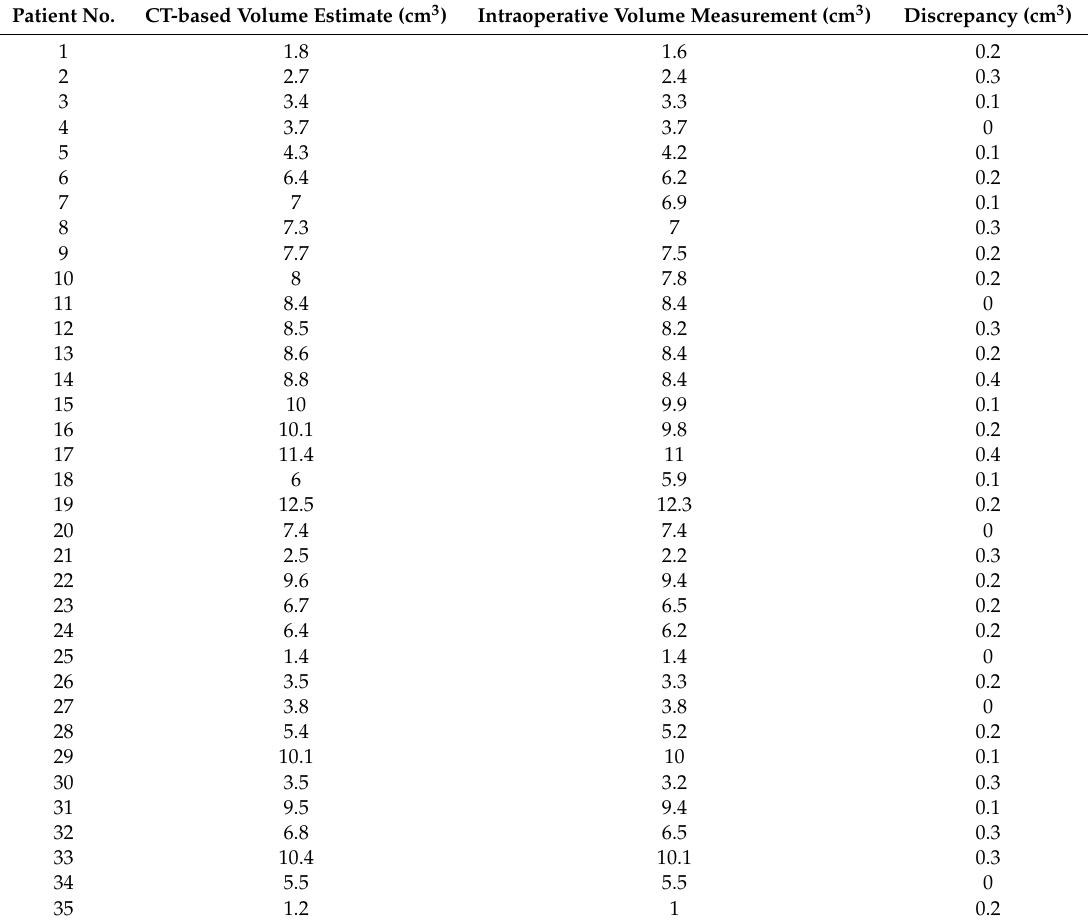
Table 1. Results of the intraoperative sphenoid sinus volume measurements and their computed tomography (CT) scan-based estimates in 40 patients. Patient